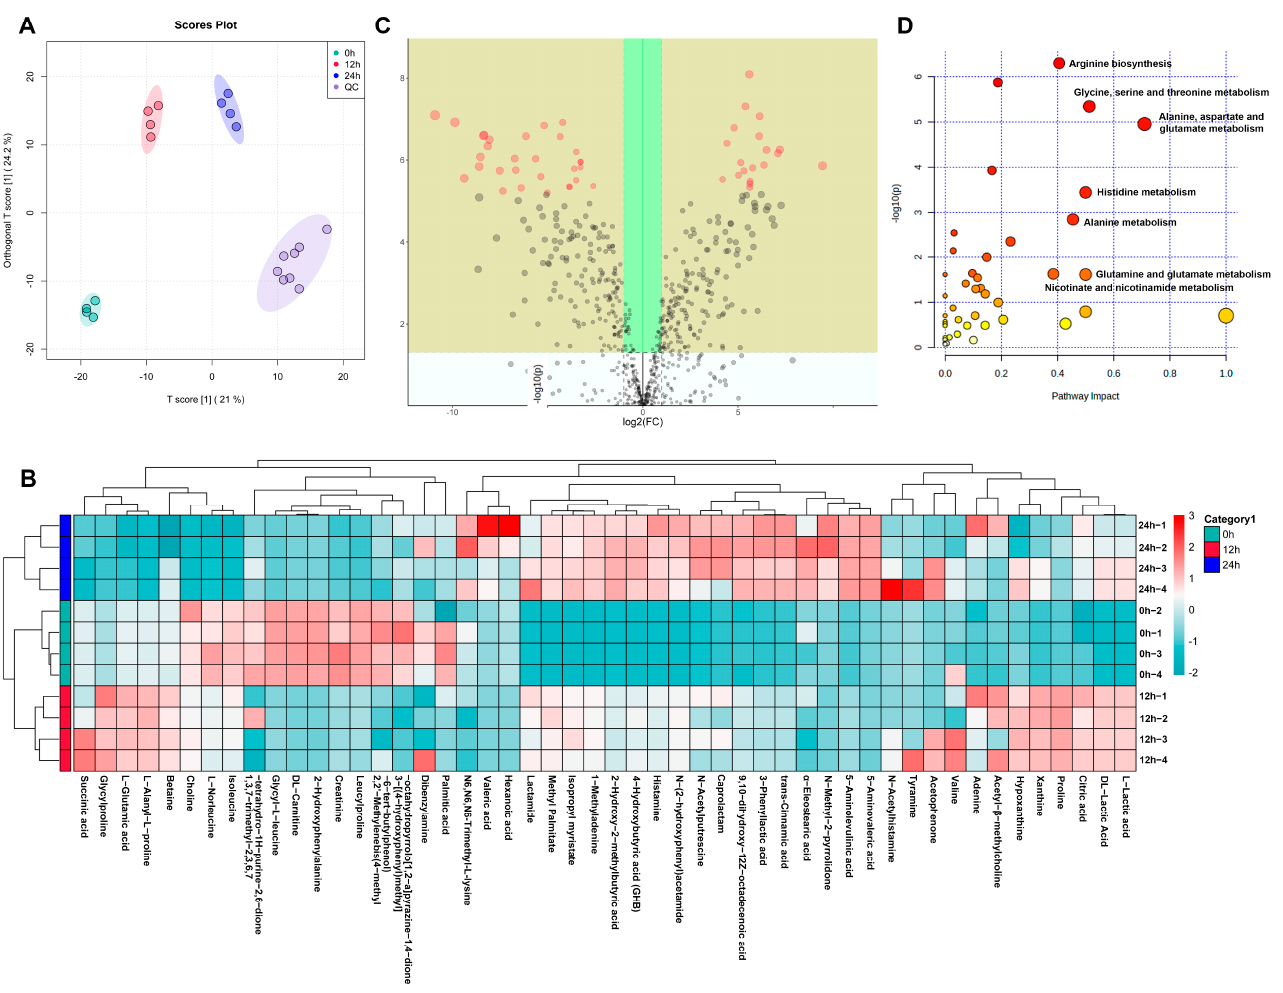
Figure 5. ABP-induced metabolic changes during in vitro fermentation. ( A ) OPLS-DA score plot from the metabolome datasets. ( B ) The cluster heatmap analysis of different metabolites. ( C ) The different metabolites between 0 and 24 h of fermentation. ( D ) Pathway analysis plots between 0 and 24 h of fermentation.